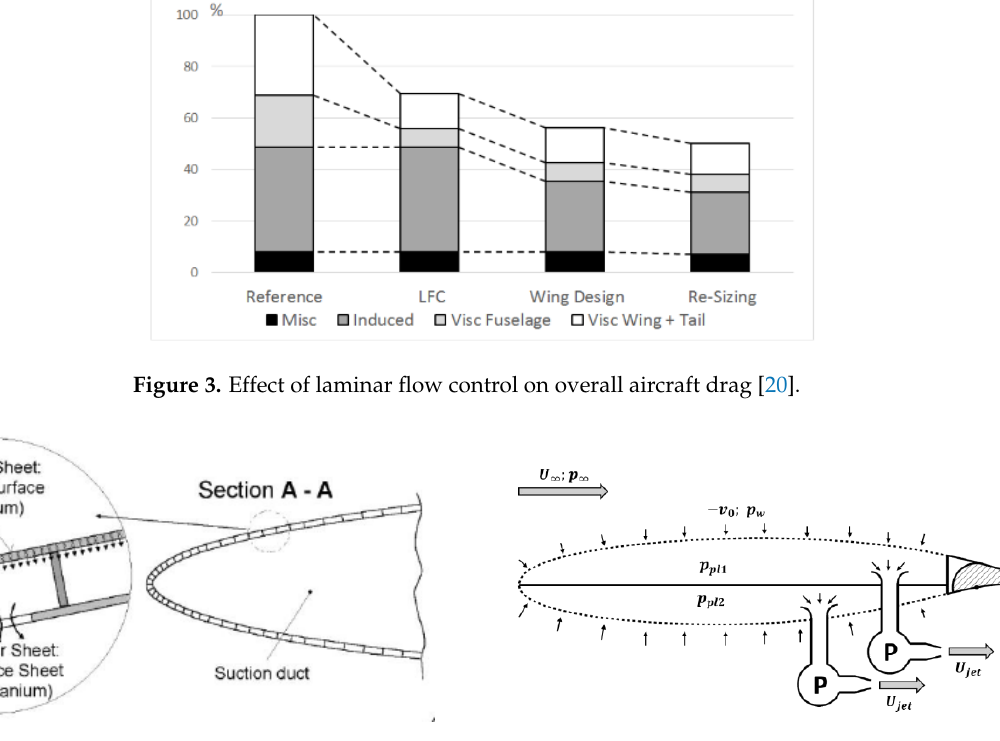
Figure 4. Schematic views of the active suction system